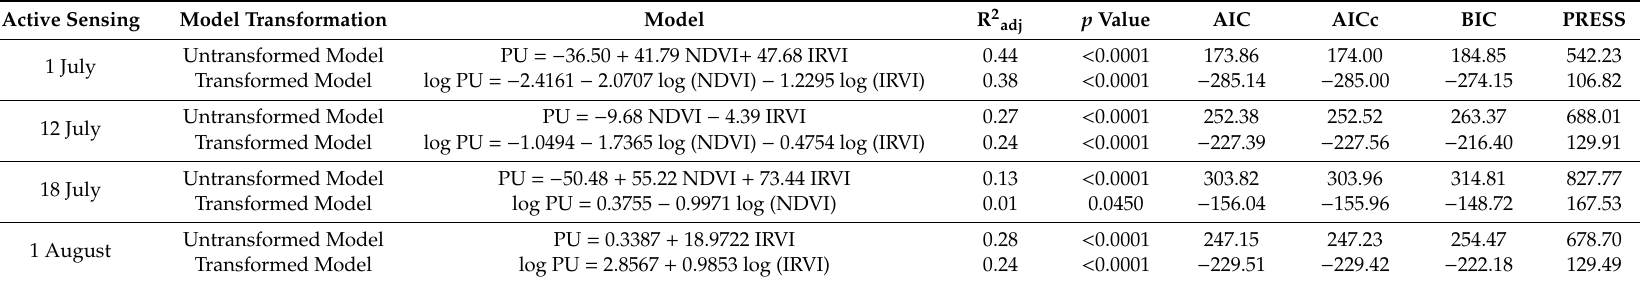
Table 7. Phosphorus uptake (kg ha − 1 ) models with adjusted coe ffi cients of determination (R 2 adj ), p Value, AICc, BIC, and PRESS for GreenSeeker ™ . Active Sensing Model